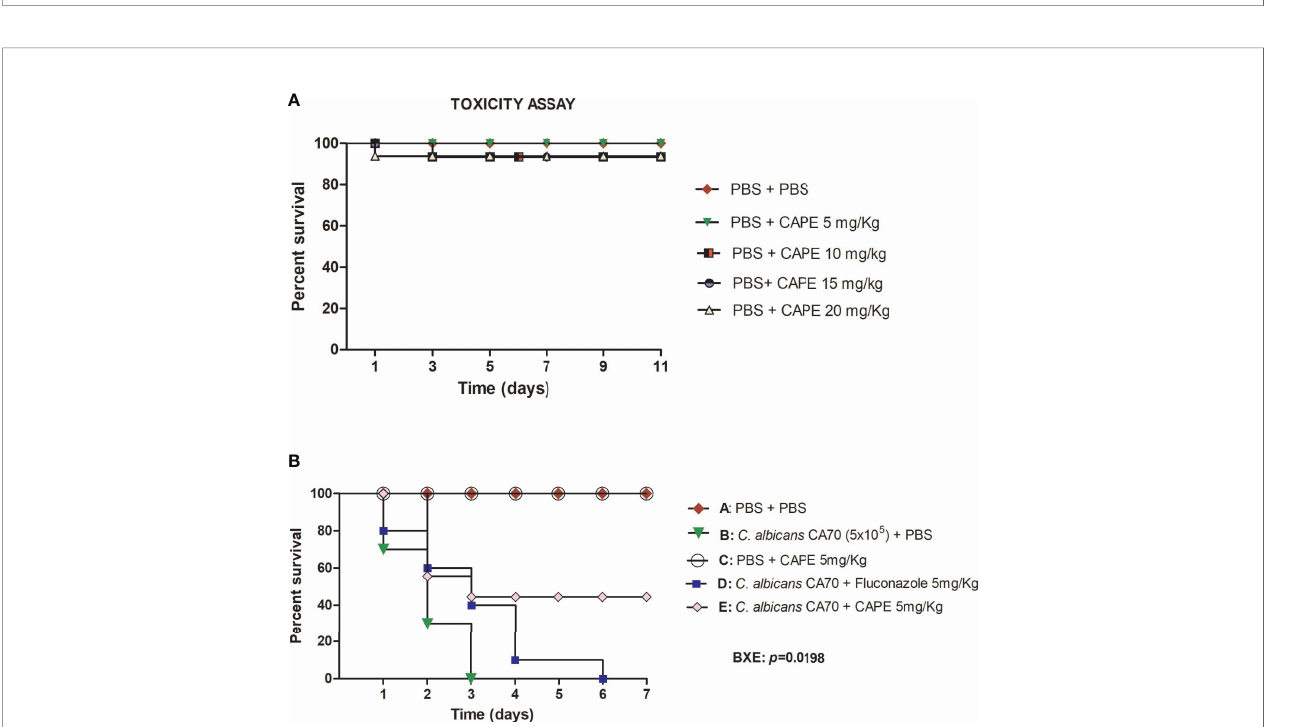
FIGURE 4 | (A) Toxicity evaluation of CAPE in G. mellonella model. G. mellonella larvae were injected with serial concentrations of CAPE and no death was observed at the concentrations used. (B) CAPE prolonged the survival of G. mellonella larvae infected with C. albicans (CA70). Signi fi cant differences were observed in survival between the “ CA70 + CAPE (5 mg/Kg) group ” and “ CA70 + PBS group ” . Kaplan-Meier test, p ≤